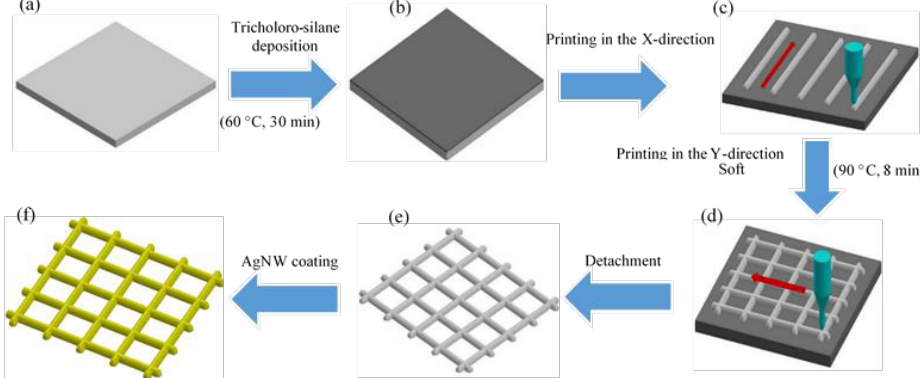
Figure 2. Procedure to obtain a free-standing PDMS mesh pattern. ( a ) A glass substrate, ( b ) a schematic of the trichloro-silane deposition process on a glass substrate and mesh pattern to obtain a functional mesh structure, ( c ) a printing step for the fabrication of the PDMS line in the X-direction, ( d ) a printing step for the fabrication of the PDMS mesh structure in the Y-direction, ( e ) detachment of the PDMS mesh structure from the glass substrate, and ( f ) AgNW coating process on the detached PDMS mesh structure.